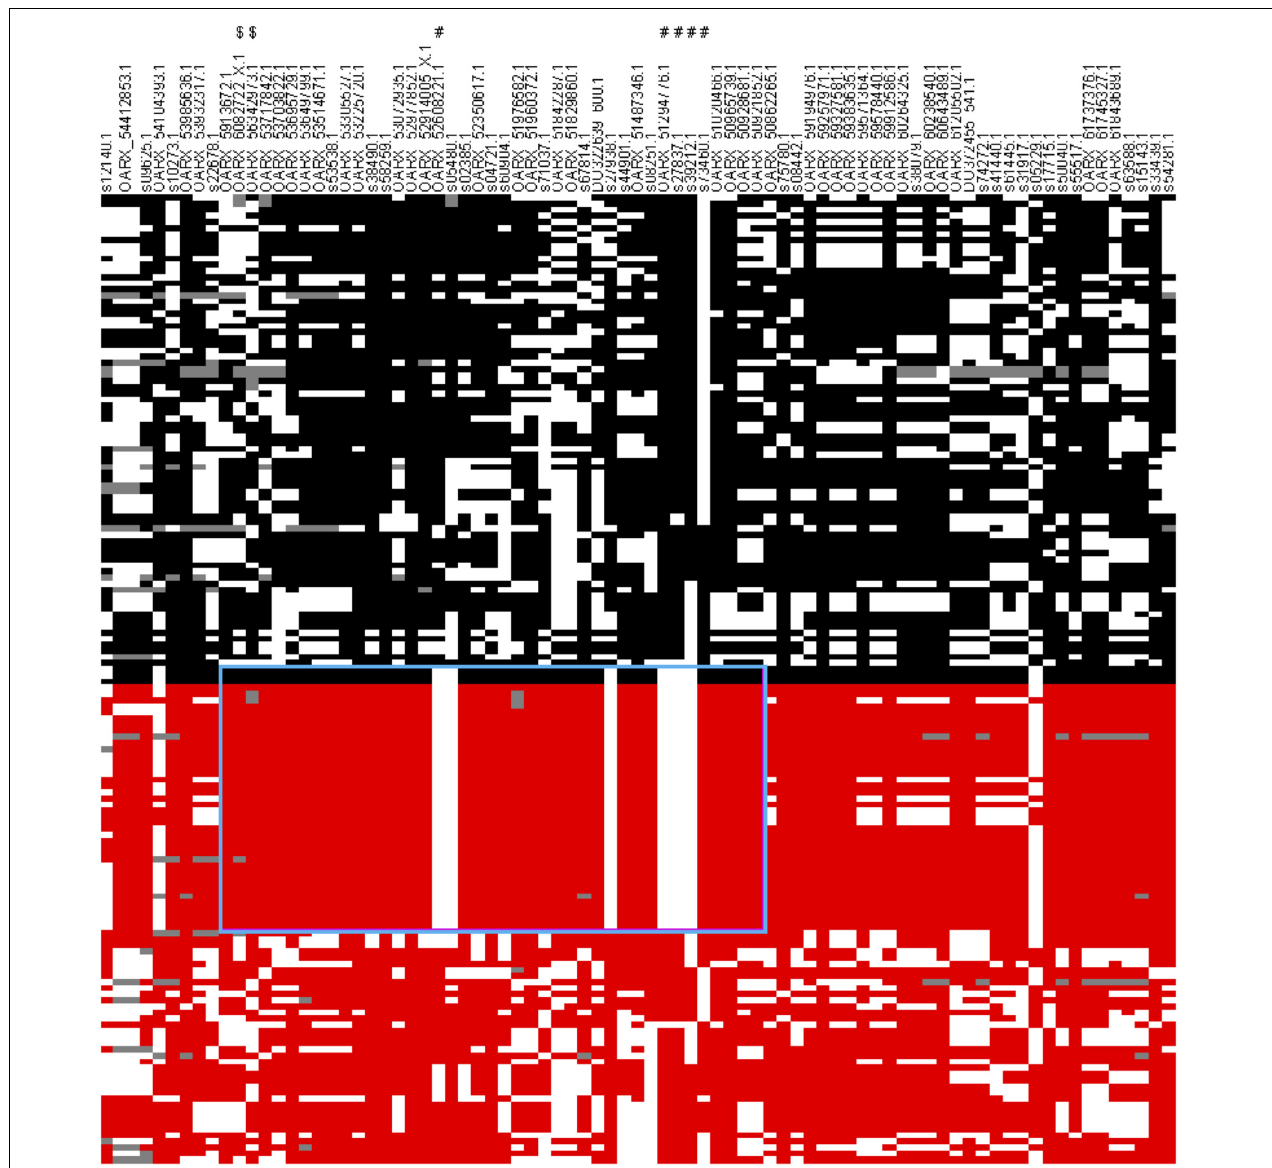
FIGURE 2 | Clusterization of haplotypes reconstructed at the OARX locus. Eighty markers encompassing the OARX region of interest (50.6–54.1 Mb) were selected to construct haplotypes from 39 cases and 40 control animals. Each column represents one SNP, and each line represents one haplotype. For one marker (i) allele 1 is in black in controls or in red in cases, (ii) allele 2 is in white when the phase was unambiguous, and (iii) gray color represents unphased SNP. Haplotypes were ordered to distinguish controls vs. cases and clusterized to classify similar clades of haplotypes. The # sign flags SNP significantly associated with LS at genome-wide level. The $ sign flags SNP flanking the BMP15 genes (50,970,938–50,977,454 bp). The specific haplotype preferentially selected in highly prolific ewes (cases) is symbolized by the cyan